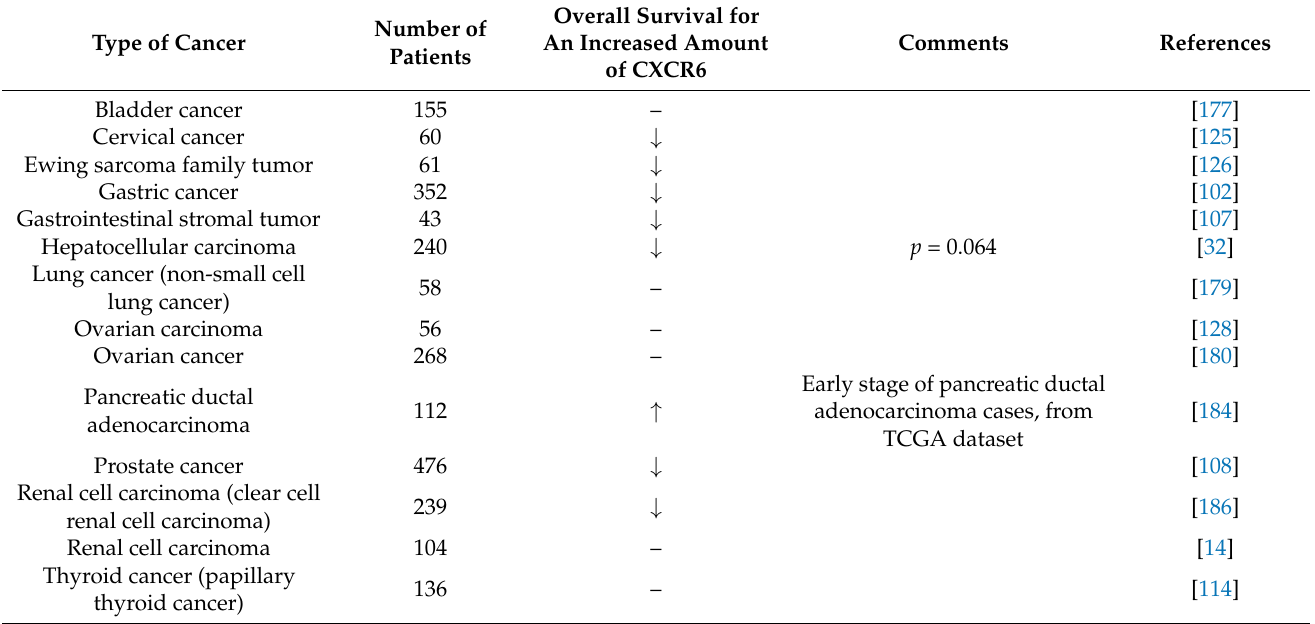
Table 5. Overall survival of patients with high tumor CXCR6